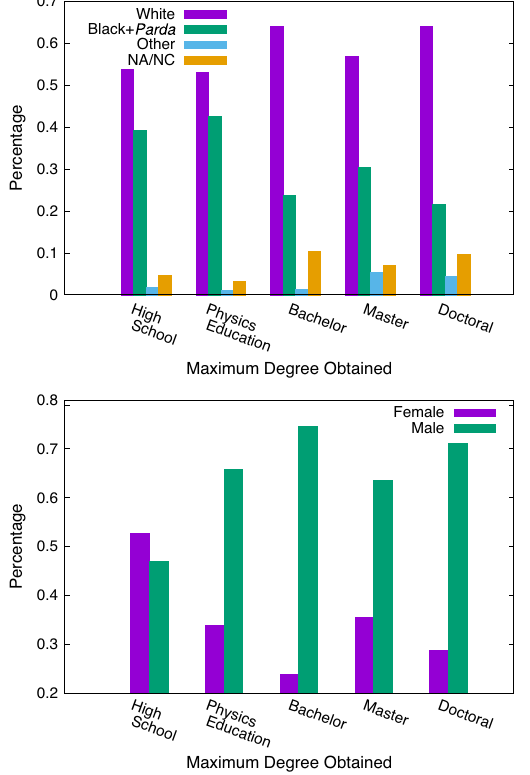
FIG. 3. Percentage of respondents vs highest degree attained, separated by race or ethnicity group (top) and by sex (bottom). In the legend, NA = NC ¼ prefer not to answer or classify them- selves. Recall that physics education and bachelor ’ s correspond to undergraduate degrees at the same level.